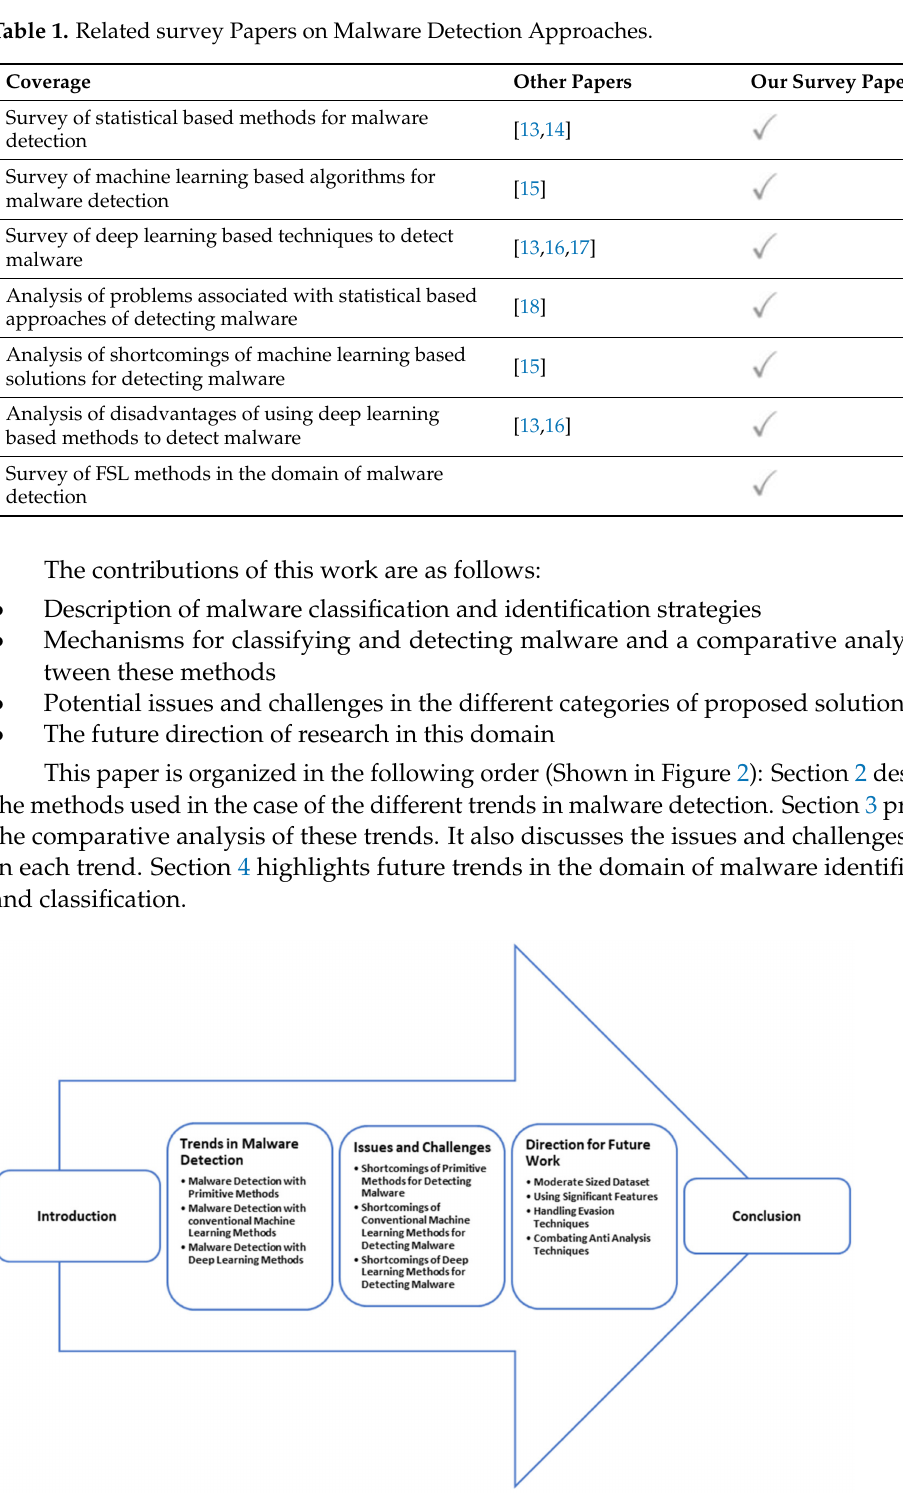
Figure 2. Organization of